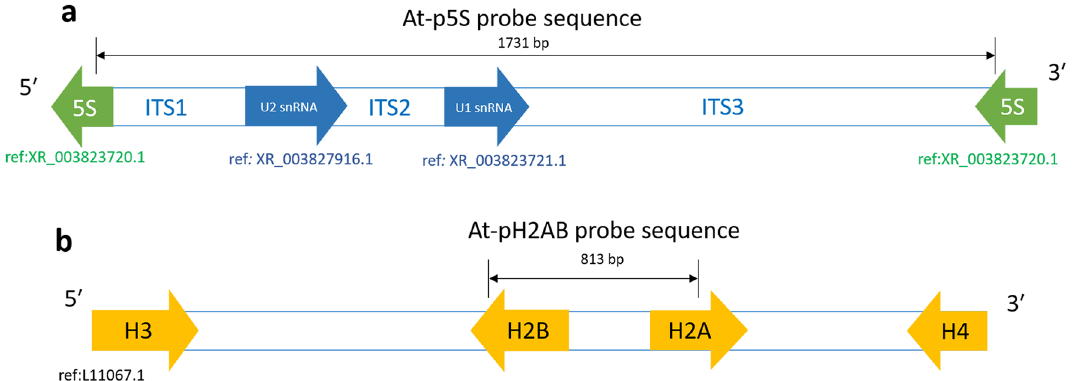
Figure 4. Characterization of the At-p5S ( a ) and At-pH2AB (b) probe sequences based on sequence alignment with their most homologous sequences from the